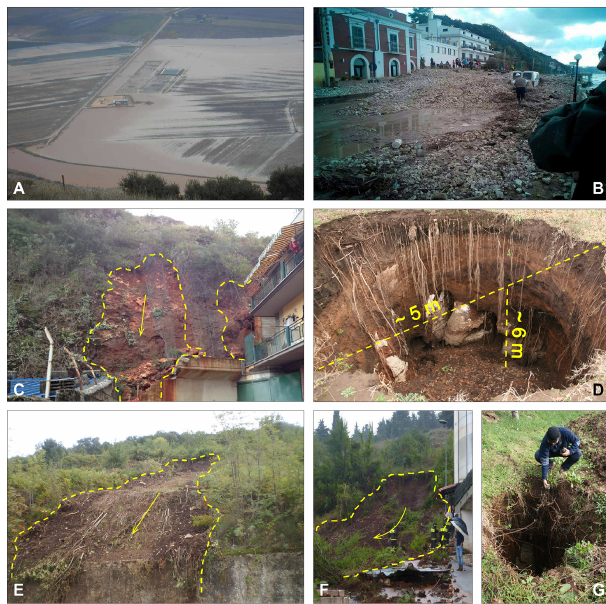
Figure 6. Examples of geohydrological hazards triggered by the 1–6 September 2014 torrential rainfall in the Gargano Promon- tory. (a) Flood plain inundated by the Candelaro River (photo- graph: Regione Puglia). (b) Inundation in Rodi Garganico (pho- tograph: Regione Puglia). (c, f) Shallow landslides in the town of San Marco in Lamis. (d) Sinkhole in San Marco in Lamis (photo- graph: M. Parise). (e) Shallow landslide in Cagnano Varano (photo- graph: Regione Puglia). (g) Sinkhole in Monte Sant’Angelo (pho- tograph: M.